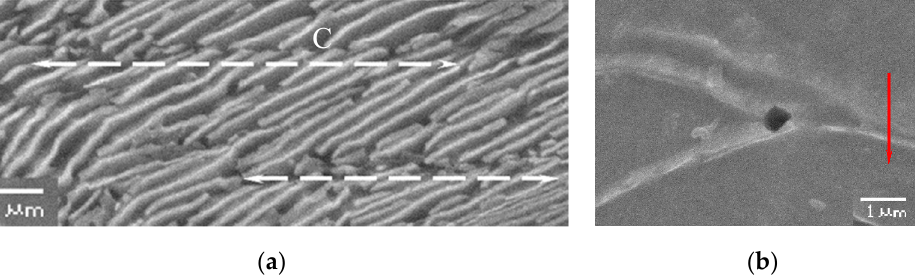
Figure 8. Microstructural damage for strain level ε z2 = 0.75: ( a ) propagation of microcracks in pearlite colonies; ( b ) nucleation of microvoids at the junction of three ferrite grains (red arrow—direction of upsetting).